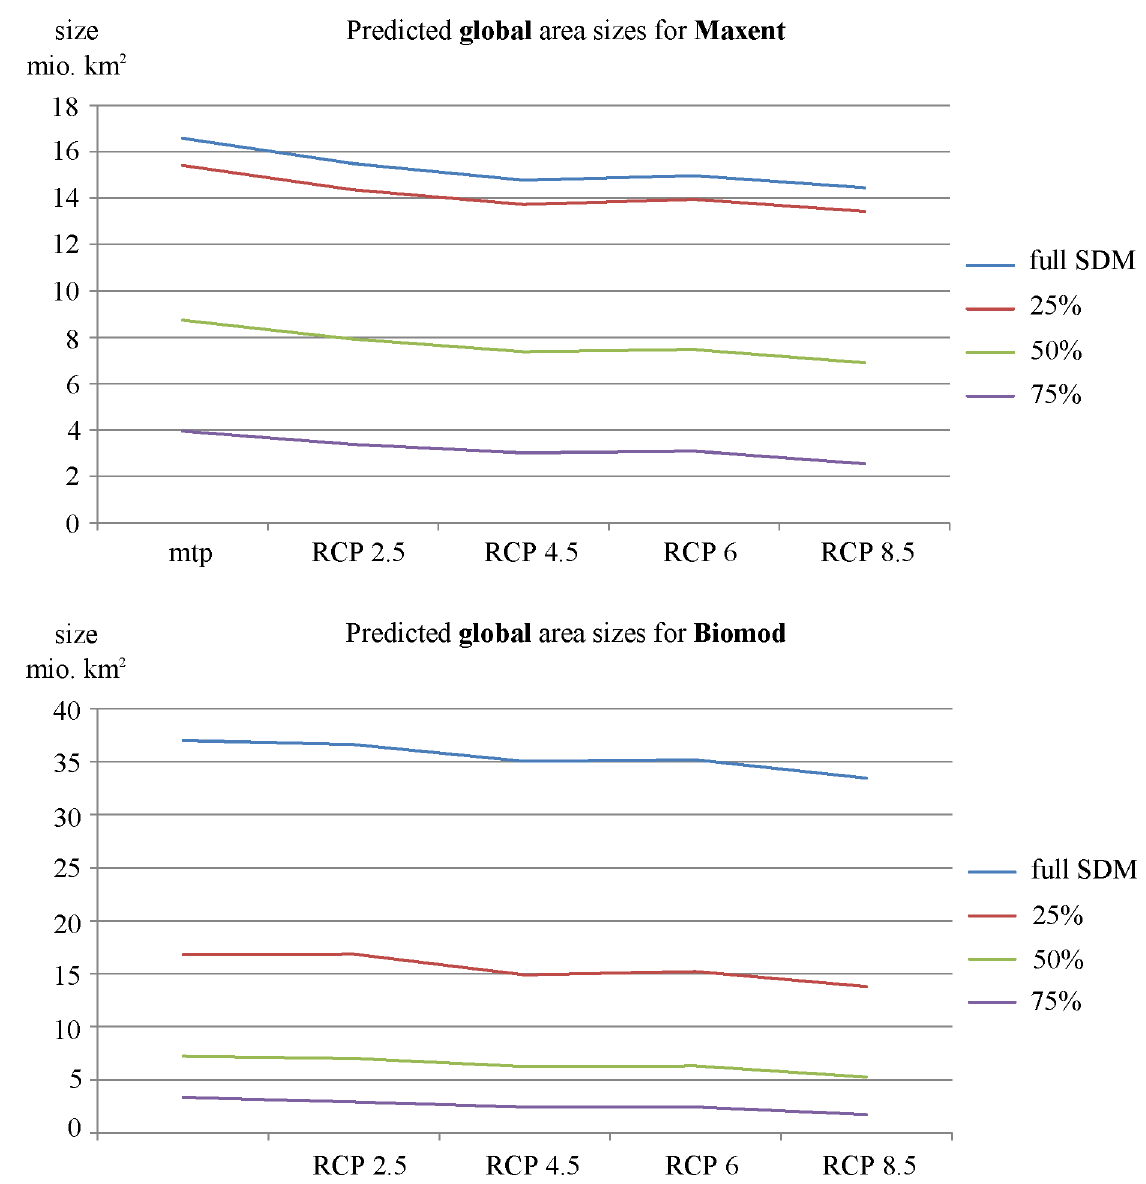
Fig 4. Predicted development of area sizes suitable for X . laevis on a global scale; a) for the Maximum entropy SDM and; b) for the ensemble SDM. Mtp = minimum training presence, all areas sizes refer to SDM area – MESS